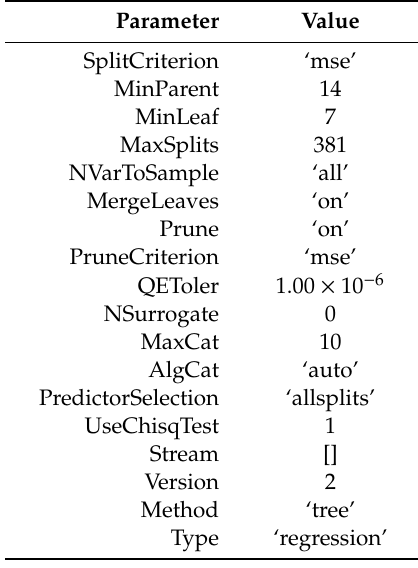
Table 3. RR decision tree